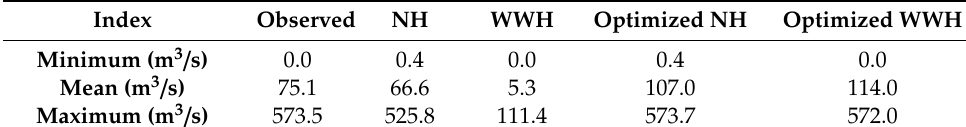
Table A1. Basic statistical parameters (minimum, mean, and maximum) at Bossey Bangou in the